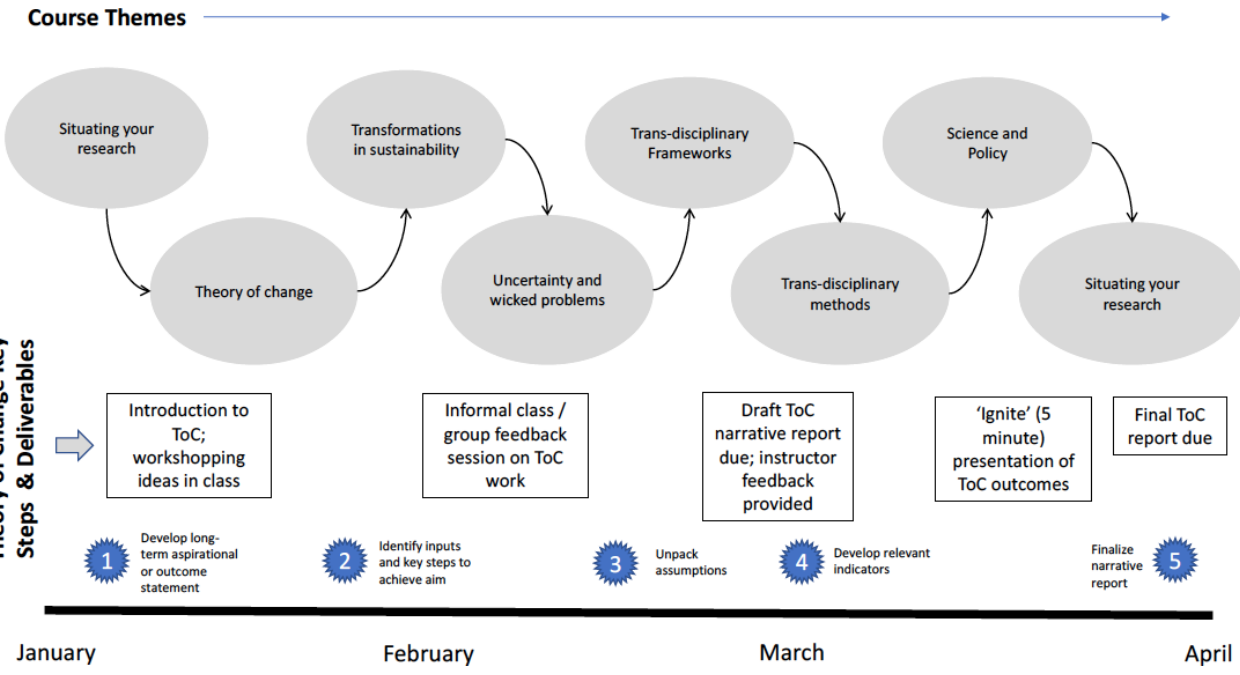
Fig. 1. Course road map, themes, steps, and theory of change